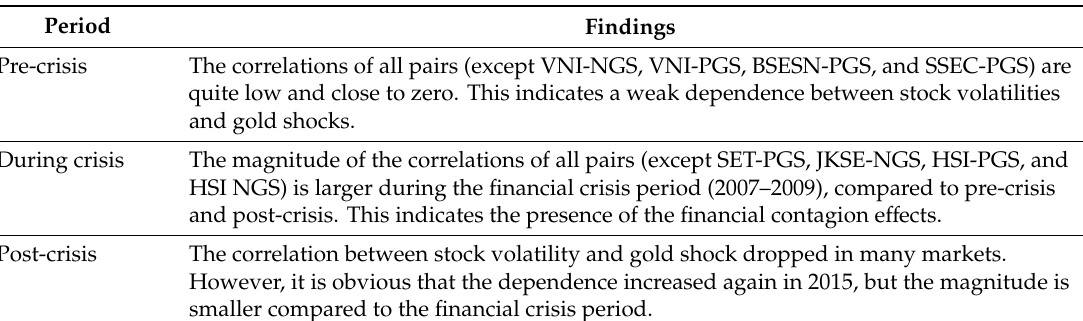
Figure 5. The evolution of the tail dependence in the BSESN-NGS and KOSPI-NGS pairs. Table 11. Summary results of time-varying Copula dependence in three